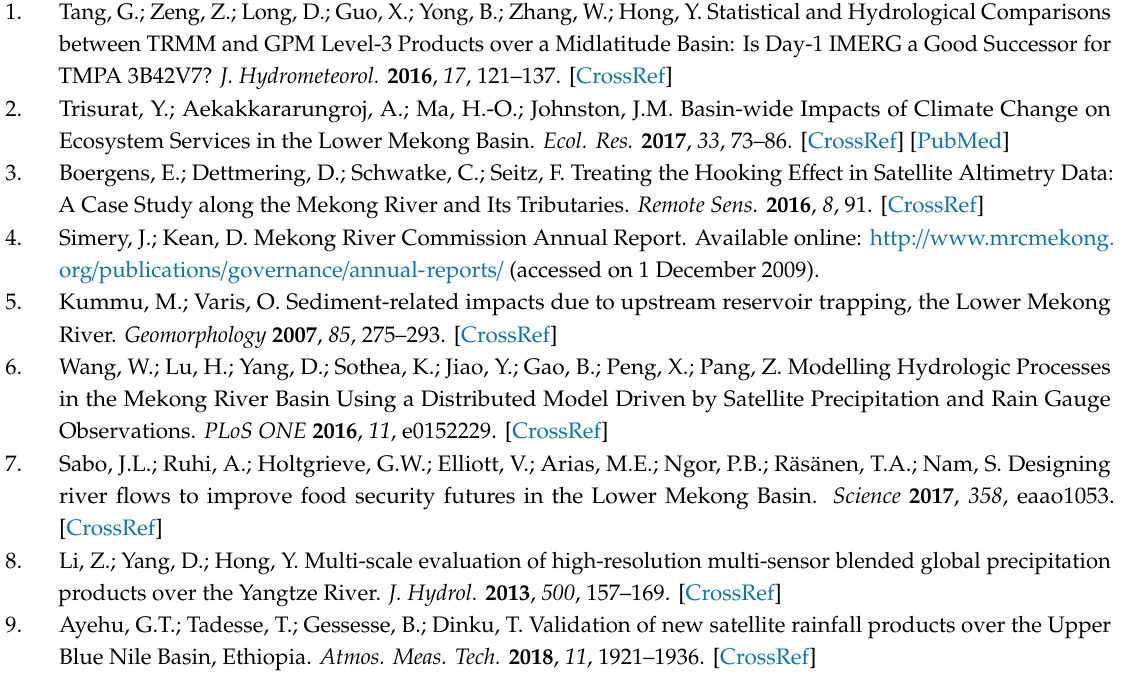
Table S1: Minimum, mean, and maximum monthly precipitation accumulations and the standard deviation for monthly, dry, wet, and annual data sets for in-situ and satellite-based estimates, Table S2: Comparison statistic results between rain gauge measurements and TMPA 3B42 v.7 satellite-based estimates for the dry season, wet season, and annually from 2000 to 2014 for mean R, bias, MAE, and RMSE, Table S3: Comparison statistic results between rain gauge measurements and CHIRPS satellite-based estimates for the dry season, wet season, and annually from 2000 to 2014 for mean r-value, bias, MAE, and